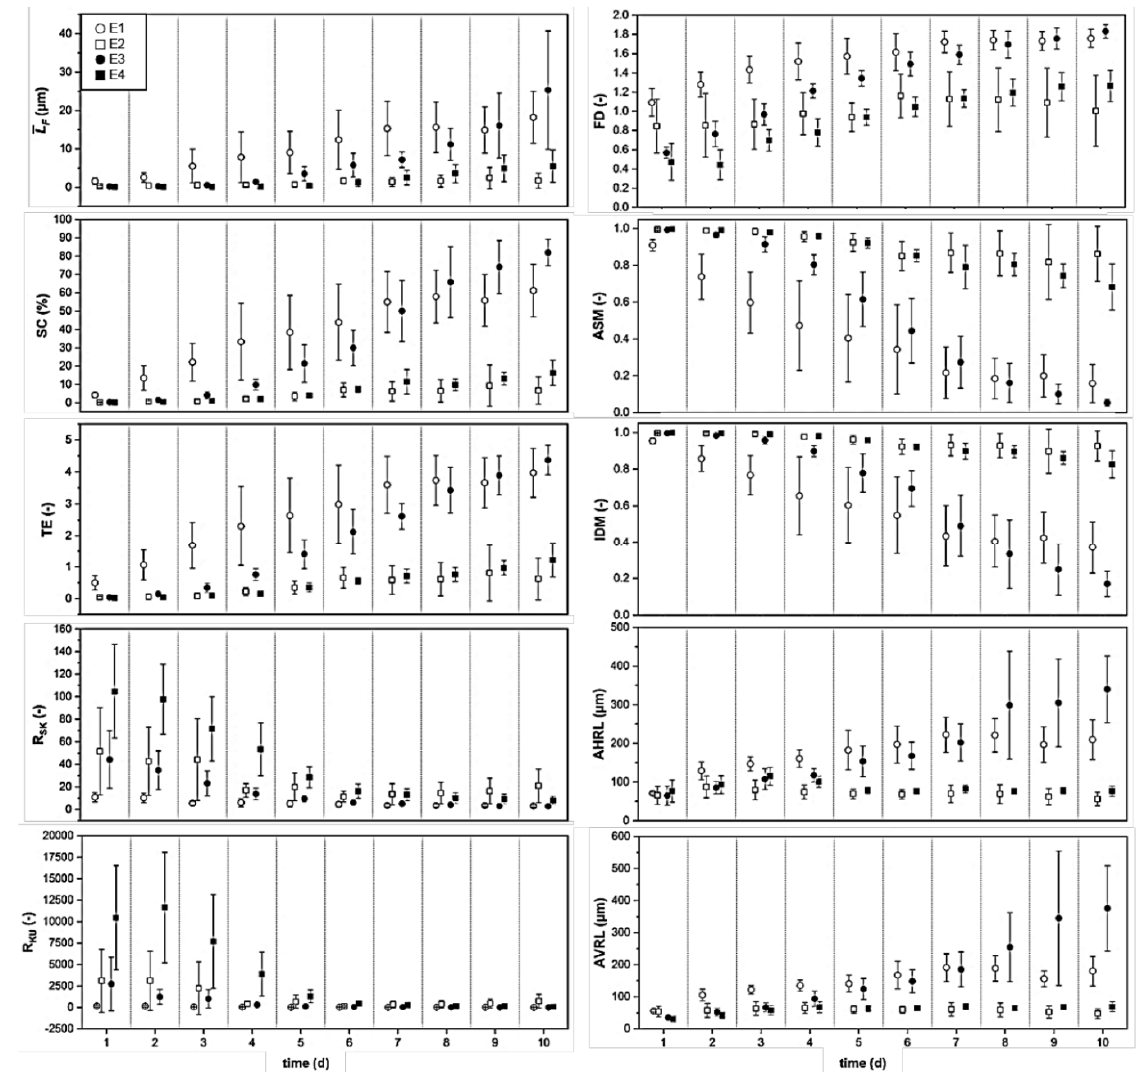
Figure 2. Comparison of the structural biofilm parameters substratum coverage ( SC ), mean biofilm thickness ( L F ), textural entropy ( TE ), kurtosis ( R KU ) , skewness ( R SK ), fractal dimension ( FD ), angular second moment ( ASM ) , inverse difference moment ( IDM ) as well as average horizontal ( AHRL ) and average vertical run lengths ( AVRL ) over the course of the experiments (10 days). Inoculation took place on day 0. An overview and meaning of the parameters are provided in Table 2. n = 10 replicates; E1/E3, ○ ● ≙ 𝑐 (cid:3007)(cid:3032) 2+ = 2.5 mg/L Fe 2+ ; E2/E4, □■ ≙ 𝑐 (cid:3007)(cid:3032) 2+ = 0.25 mg/L Fe 2+ ; opened data points ≙ u = 0.75 cm/s; closed data points ≙ u = 3.75 cm/s.